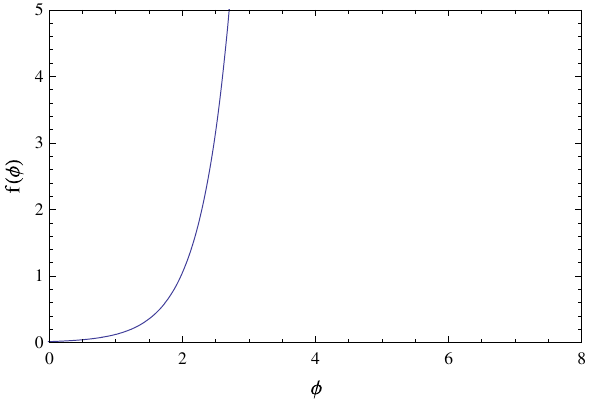
Fig. 8 Variation of V (φ) with the variation of φ for the linear param- eterization (Model